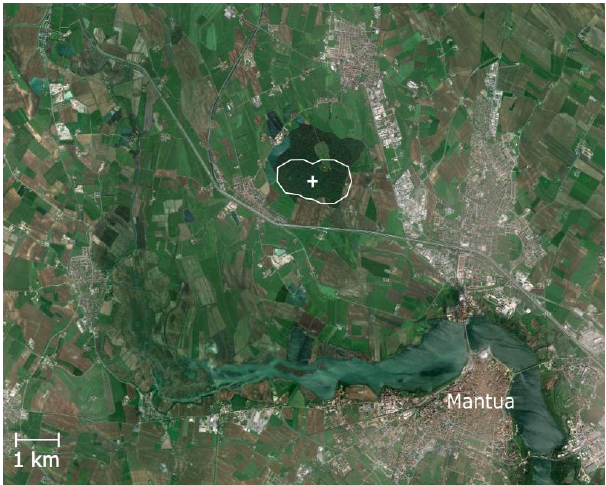
Figure 1. Satellite picture (imagery © 2015 Cnes/Spot Image, DigitalGlobe, European Space Imaging, Landsat, map data © 2015 Google) of the Bosco Fontana national park and the surroundings. The position of the flux tower is marked by a white cross and sur- rounded by the mean 80% of the flux footprint, which is represented by the white line (Acton et al., 2016). The dark green surrounding is the forest area of the national